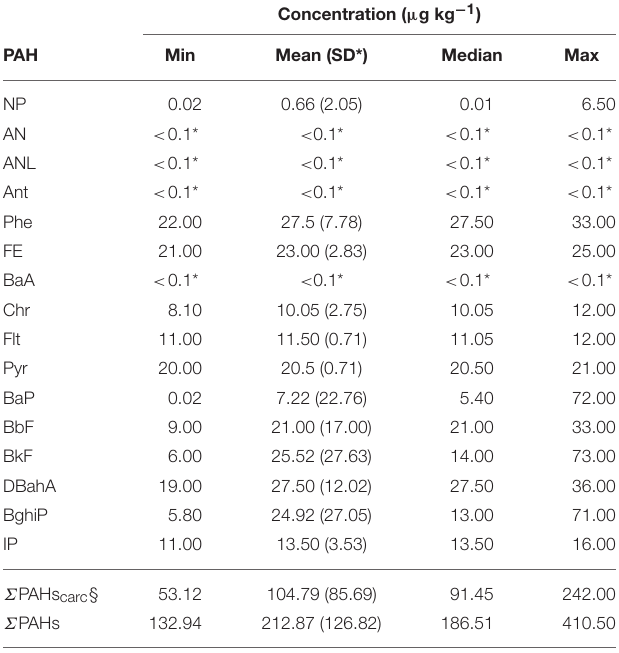
TABLE 5 | Physicochemical characteristics of the uncontrolled soil profiles of the community gardens.